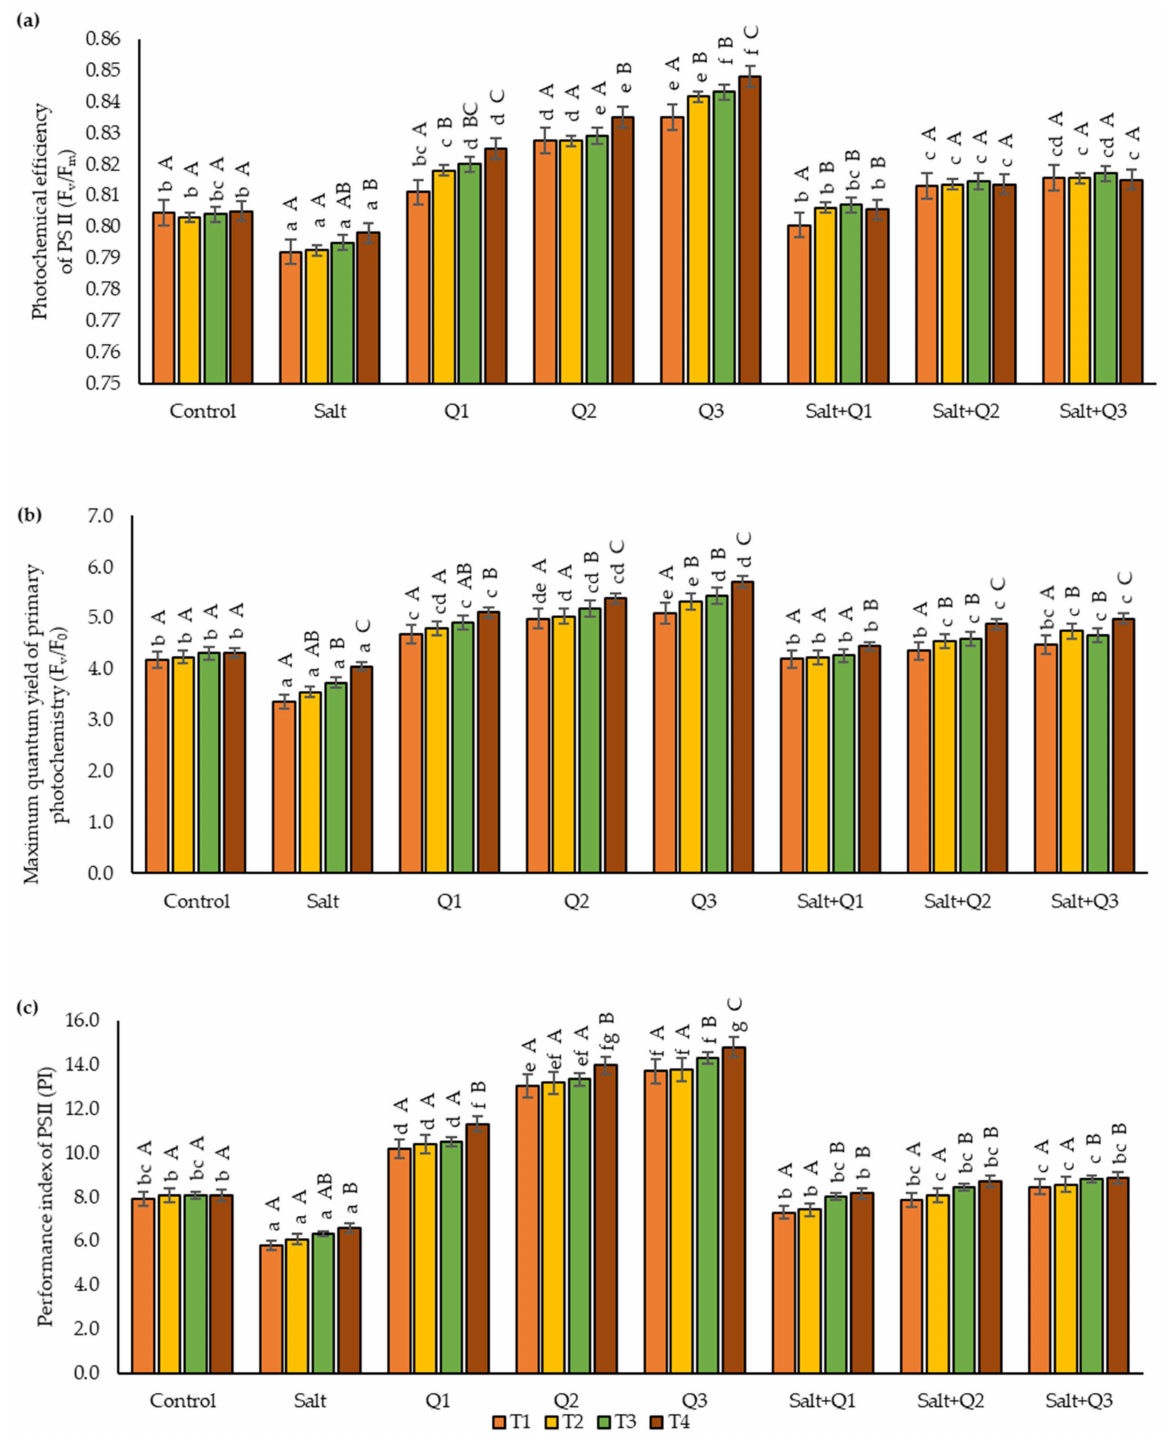
Figure 2. Effect of quercetin–copper complex (Q-Cu (II)) concentrations, salt stress, and terms of mea- surement on chlorophyll fluorescence parameters: ( a ) the photochemical efficiency of PS II (F v /F m ); ( b ) the maximum quantum yield of primary photochemistry (F v /F 0 ), and ( c ) the performance index of PS II (PI). (T1—the first day after the first application, T2—the seventh day after the first application, T3—the first day after the second application, T4—the seventh day after the second application). Capital letters indicate significant differences between the means at measurement terms for each variant of the experiment, lowercase letters indicate significant differences between the means at respective measurement term according to ANOVA followed by Tukey’s HSD test, p =